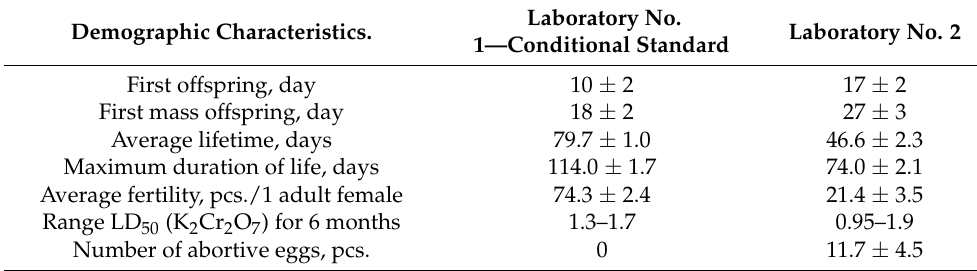
Table 2. Demographic characteristics of D. magna cultures in two bioassay laboratories. Demographic Characteristics.